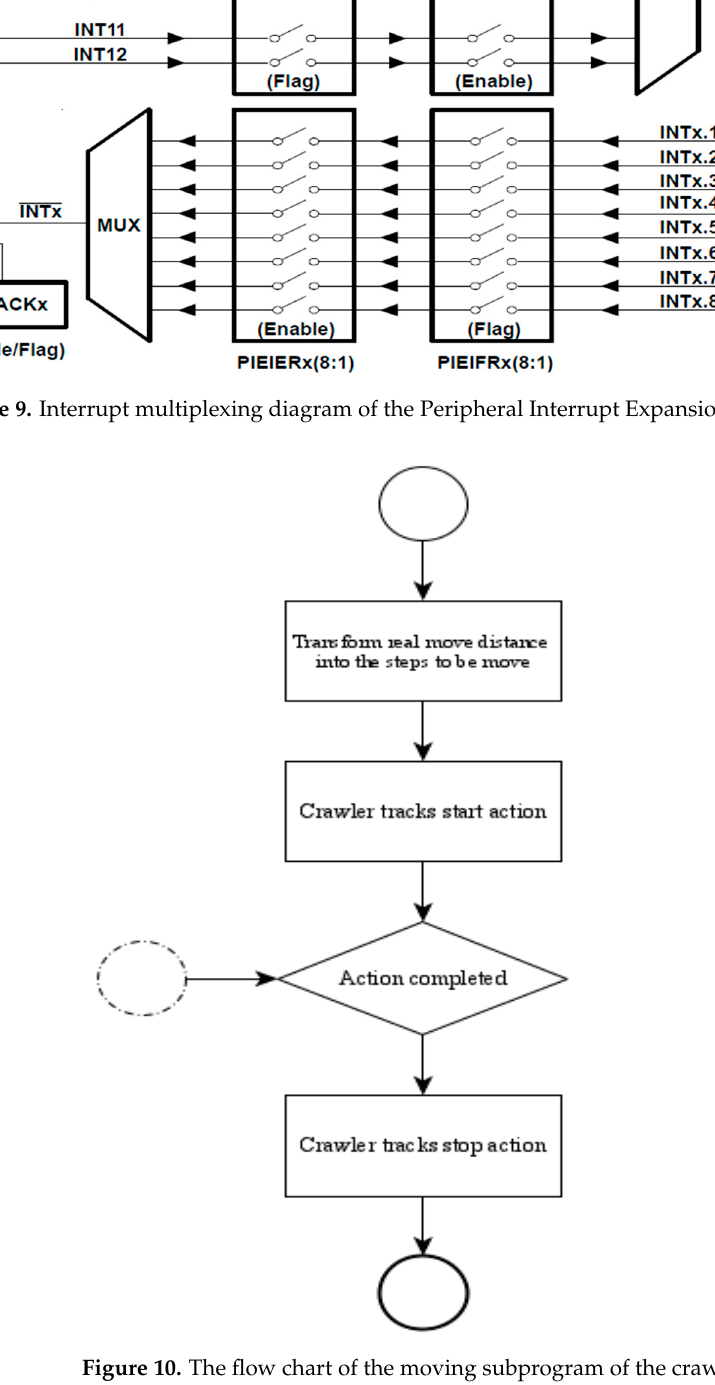
Figure 10. The flow chart of the moving subprogram of the crawler tracks.